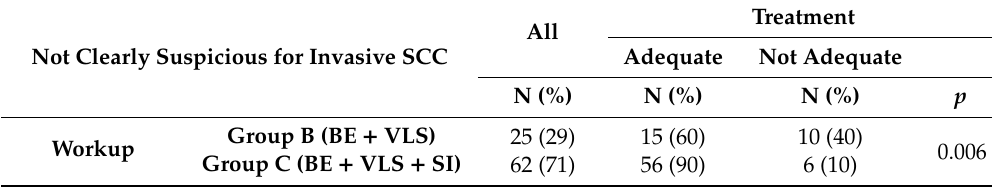
Table 4. Association between Groups B and C and adequacy of treatment.